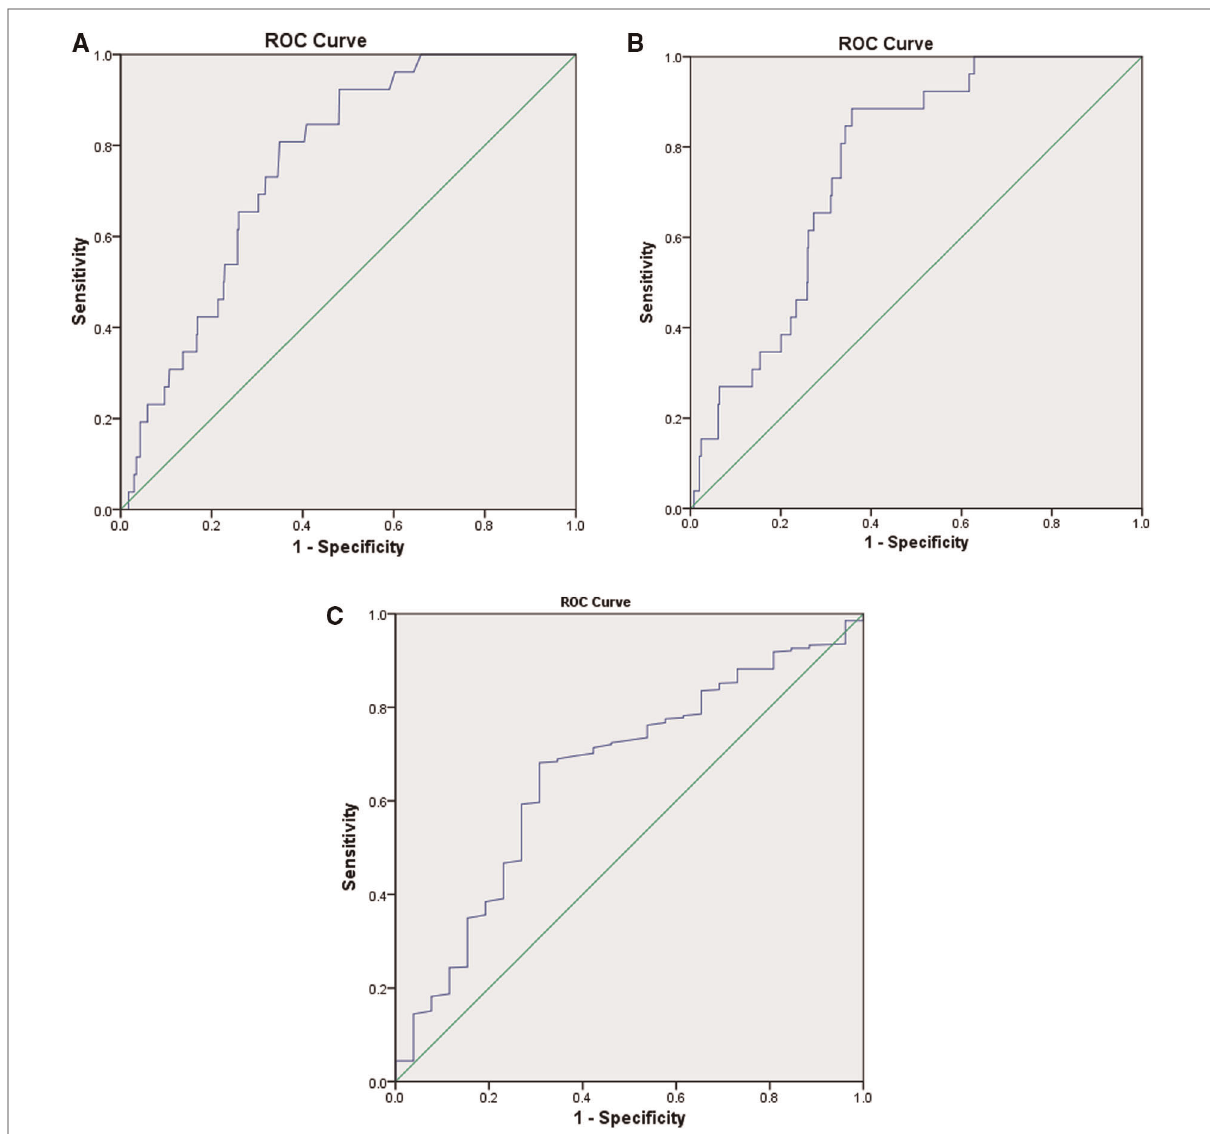
FIGURE 1 The ROC curves were constructed to determine the optimal cut-off values for CLR, CRP, and lymphocyte count. The optimal cut-off of CLR was 2.1, corresponding to a sensitivity of 0.856, speci fi city of 0.643, and an AUC of 0.768 (95% CI, 0.737 – 0.797) ( A ). The optimal value of CRP was 4.0 mg/L, corresponding to a sensitivity of 0.808, speci fi city of 0.651, and AUC of 0.759 (95% CI, 0.727 – 0.789) ( B ); while for lymphocyte count, the cut-off value was 1.5, and the sensitivity, speci fi city, and AUC was 0.681, 0.692, and 0.660 (95% CI, 0.555 – 0.765) ( C ). AUC, area under the curve; CLR, C-reactive protein to lymphocyte ratio; CRP, C-response protein; ROC, receiver operator